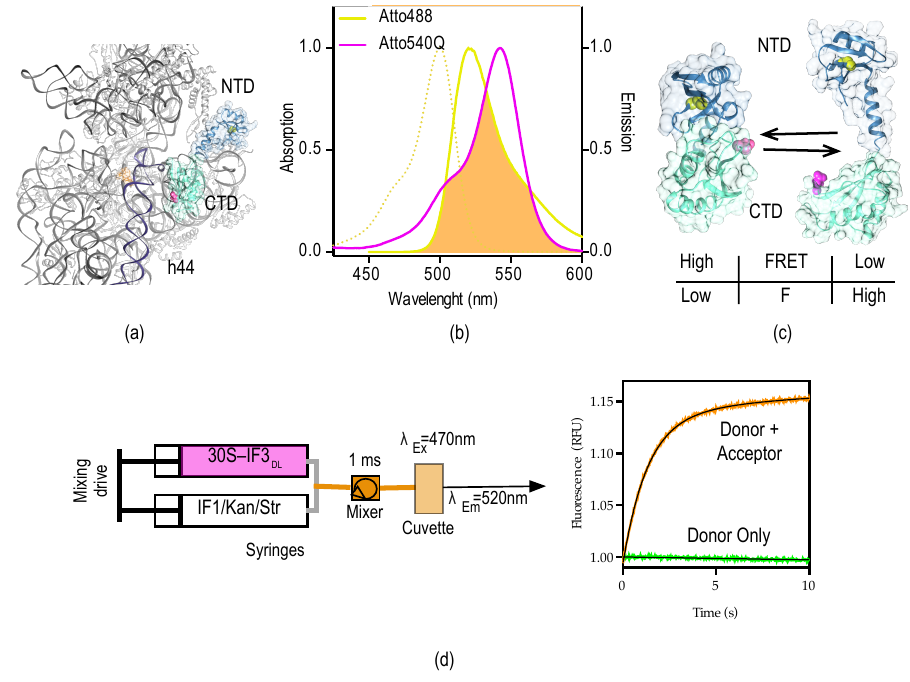
Figure 2. IF3 DL intramolecular FRET for dynamic measurements of the 30S platform. ( a ) Crystal structure of the 30S subunit, depicting a possible orientation of IF3 across the platform, CTD (turquoise), and NTD (steel blue); ( b ) absorption and emission spectra of Atto-488 fluorescent dye (yellow) and Atto-540Q quencher (purple). The overlap area between donor emission fluorescence (Atto-488) and acceptor absorption of quencher (Atto-540Q) is indicated in orange. R 0 distance for the FRET couple is 64 Å according to the producer (Atto-tec, Siegen, Germany); ( c ) Potential arrangements of IF3 domains with respect to each other. Colors are as in ( a ); cysteine residues for donor (C65, yellow) and acceptor (E166C, purple) dyes are shown as spheres. The bottom table indicates the possible readouts of fluorescence and FRET for the corresponding states of IF3 DL ; ( d ) Scheme of stopped-flow experimental set-up and the typical signal read out upon mixing 30S–IF3 DL with a 30S binder (orange trace). In order to assign the signal as FRET, the same experiment is performed in the absence of the acceptor, in this case IF3 NAtto488 , IF3 labeled at the natural cysteine in the NTD (green